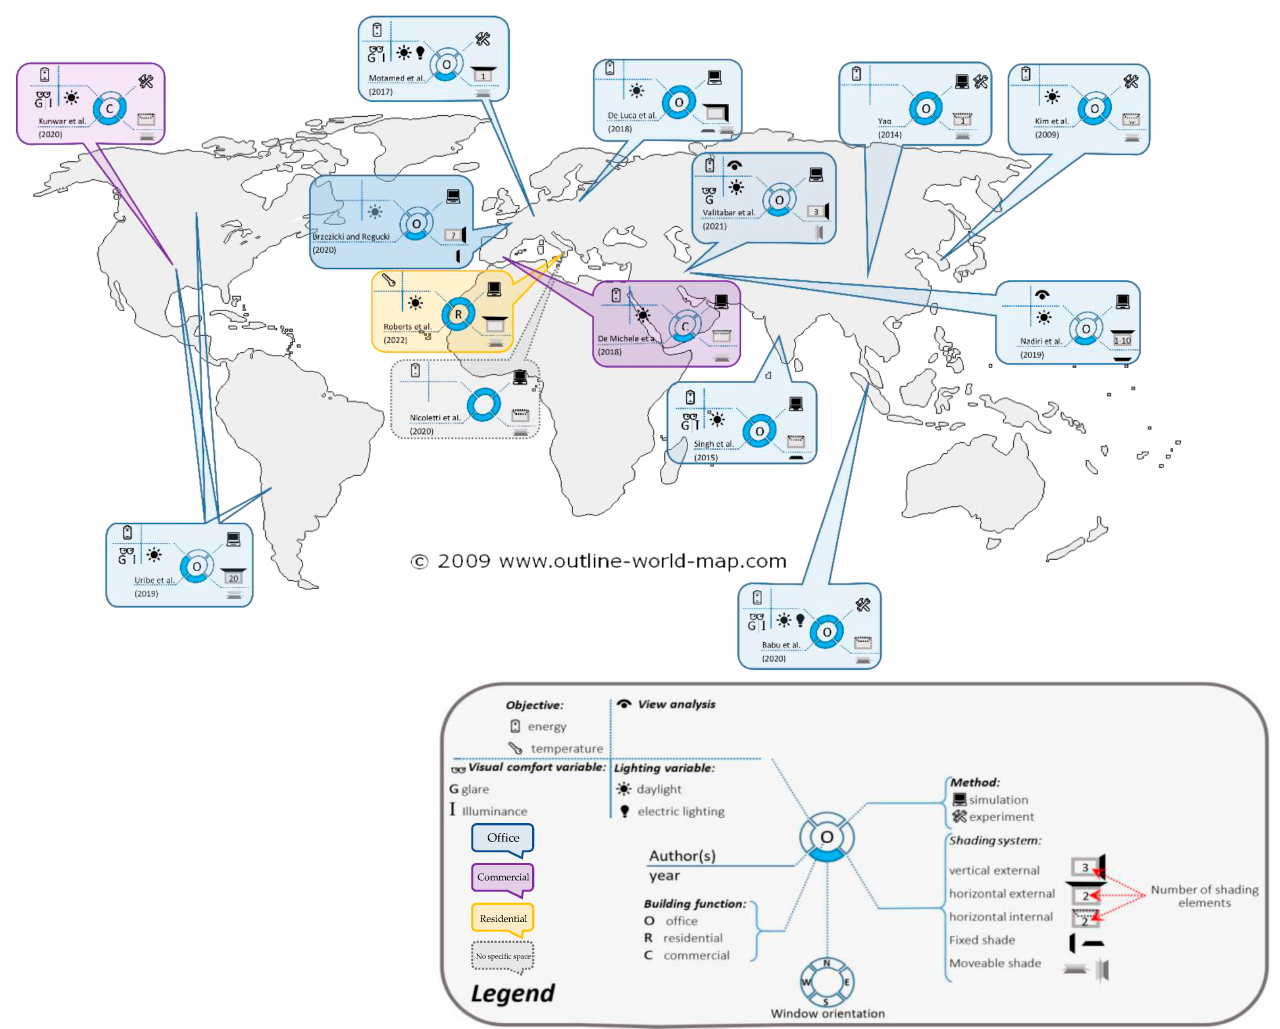
Figure 1. An overview of similar studies.